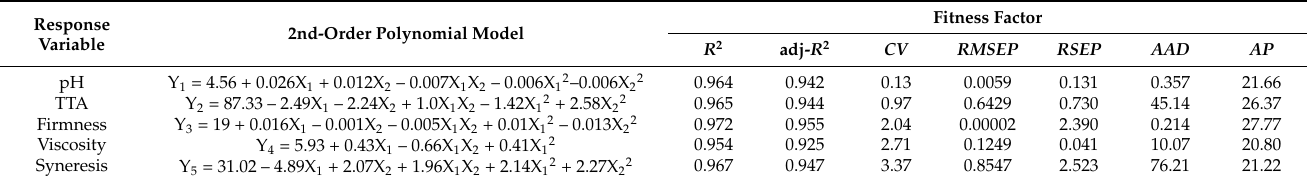
Table 4. Final reduced second-order polynomial models and their fitness quality parameters for response variables.